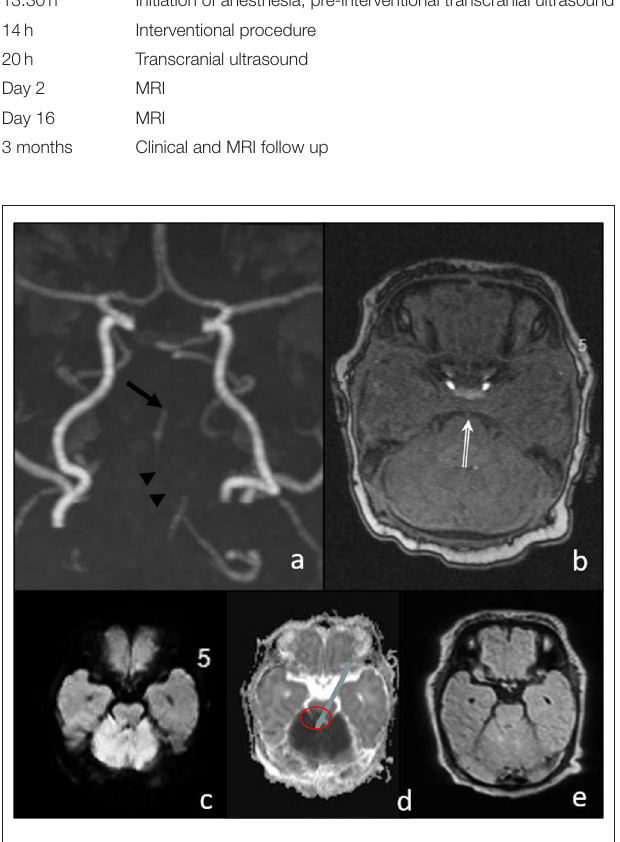
FIGURE 1 | Magnetic resonance imaging (MRI) before intervention. (a,b) TOF shows the stop of flow signal in the distal basilar artery (arrow in a and double arrow in (b) , and a discontinuous flow signal in the proximal basilar artery (arrowheads); (c) diffusion-weighted imaging (DWI) MRI signal elevation and ADC decrease (d) in the cerebellum corresponding to SCA territory without significant FLAIR changes (e) . Only small diffusion restriction in the brain stem (medulla